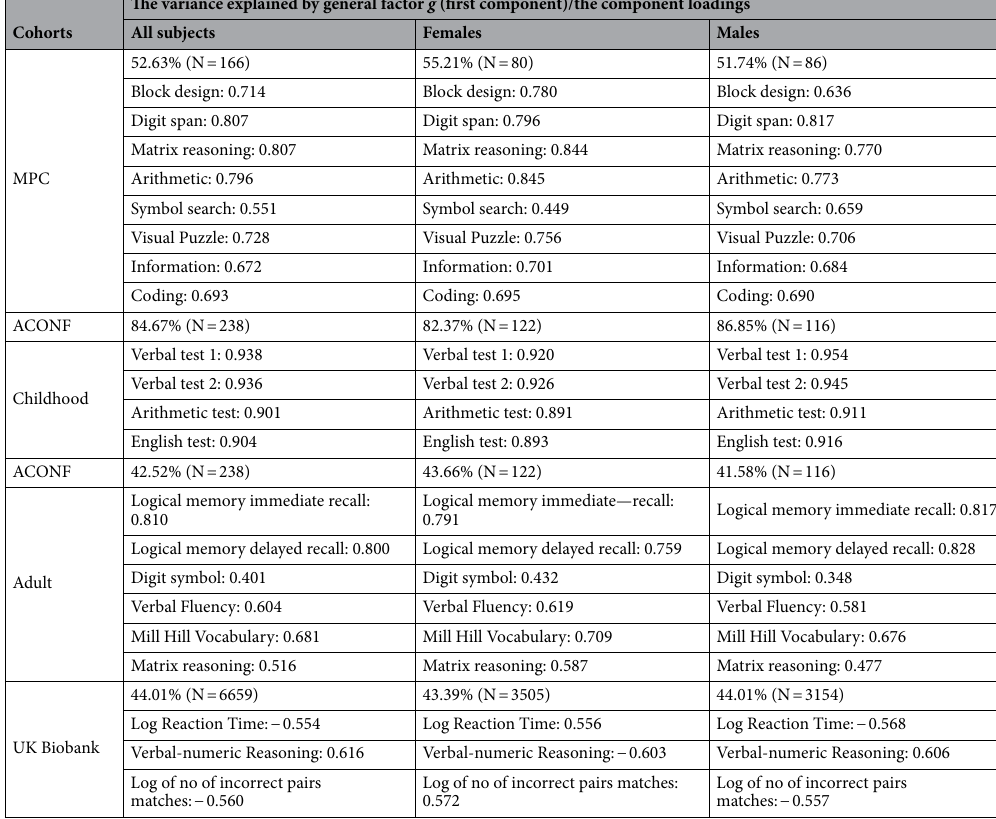
Table 3. The first unrotated component and how much it accounts for the variance in the scores for all subjects and the component loadings.